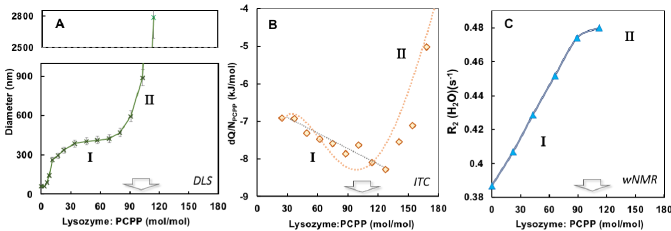
Figure 3. Comparison of DLS, ITC and w NMR titration results. ( A ) Dependence of z-average hydrodynamic diameters ( B ) incremental heat per polymer molar concentration, and ( C ) water proton transverse relaxation rate on the protein-to-polymer ratios (0.5 mg/mL PCPP was titrated with 10 mg/mL lysozyme, PBS, pH 7.4). Comparison of w NMR and DLS data also reveals that the former method is able to detect changes in the range of protein-to-polymer molar ratios (up to 5), in which DLS